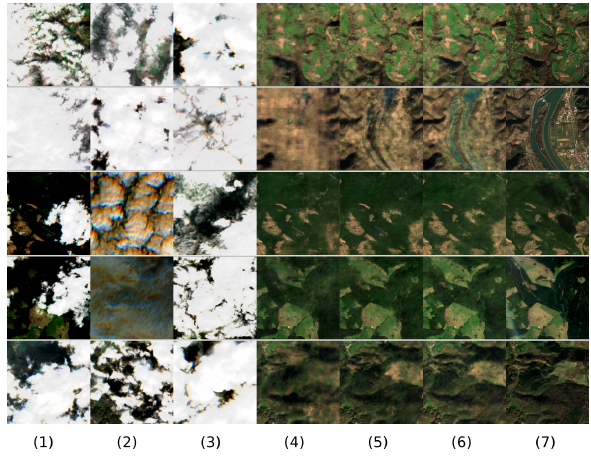
Figure 11. From left to right: input images S 2 t − 1 (1), S 2 t (2), S 2 t +1 (3), output reconstructed optical images (cid:100) S 2 t from MSOP unet,w/oSAR (4), MSOP unet (5), MSOP unet + DEM (6) and the reference image S 2 t (cid:48) (7).